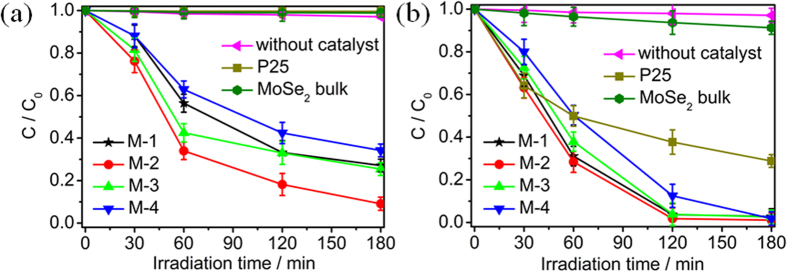
Photocatalytic reduction of Cr(VI) by P25, MoSe2 bulk, M-1, M-2, M-3 and M-4 under (a) visible and (b) UV light irradiation.